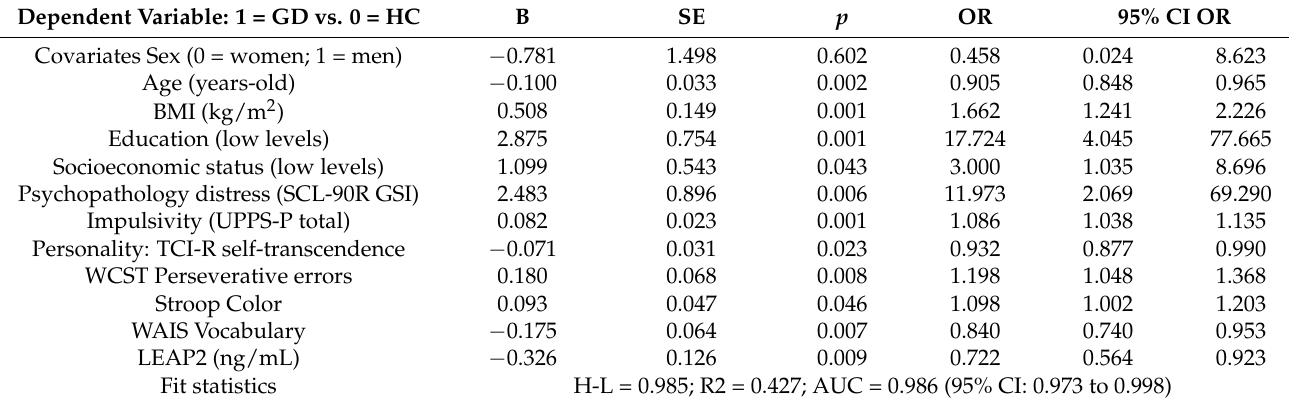
Table 3. Predictive logistic regression model for identifying